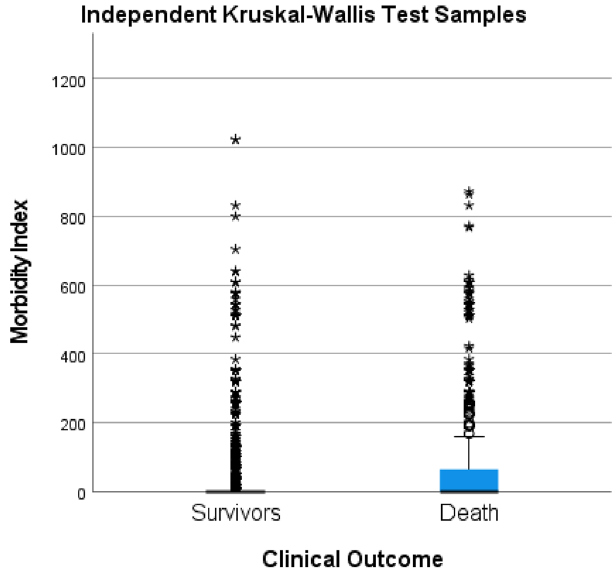
Figure 5. Comparison of the morbidity rate between the clinical outcomes, survivor and death, of cases of SARS-CoV-2 infection in the State of Pará-Amazon-Brazil, 2020. Source: OpenDataSUS, Ministry of Health.